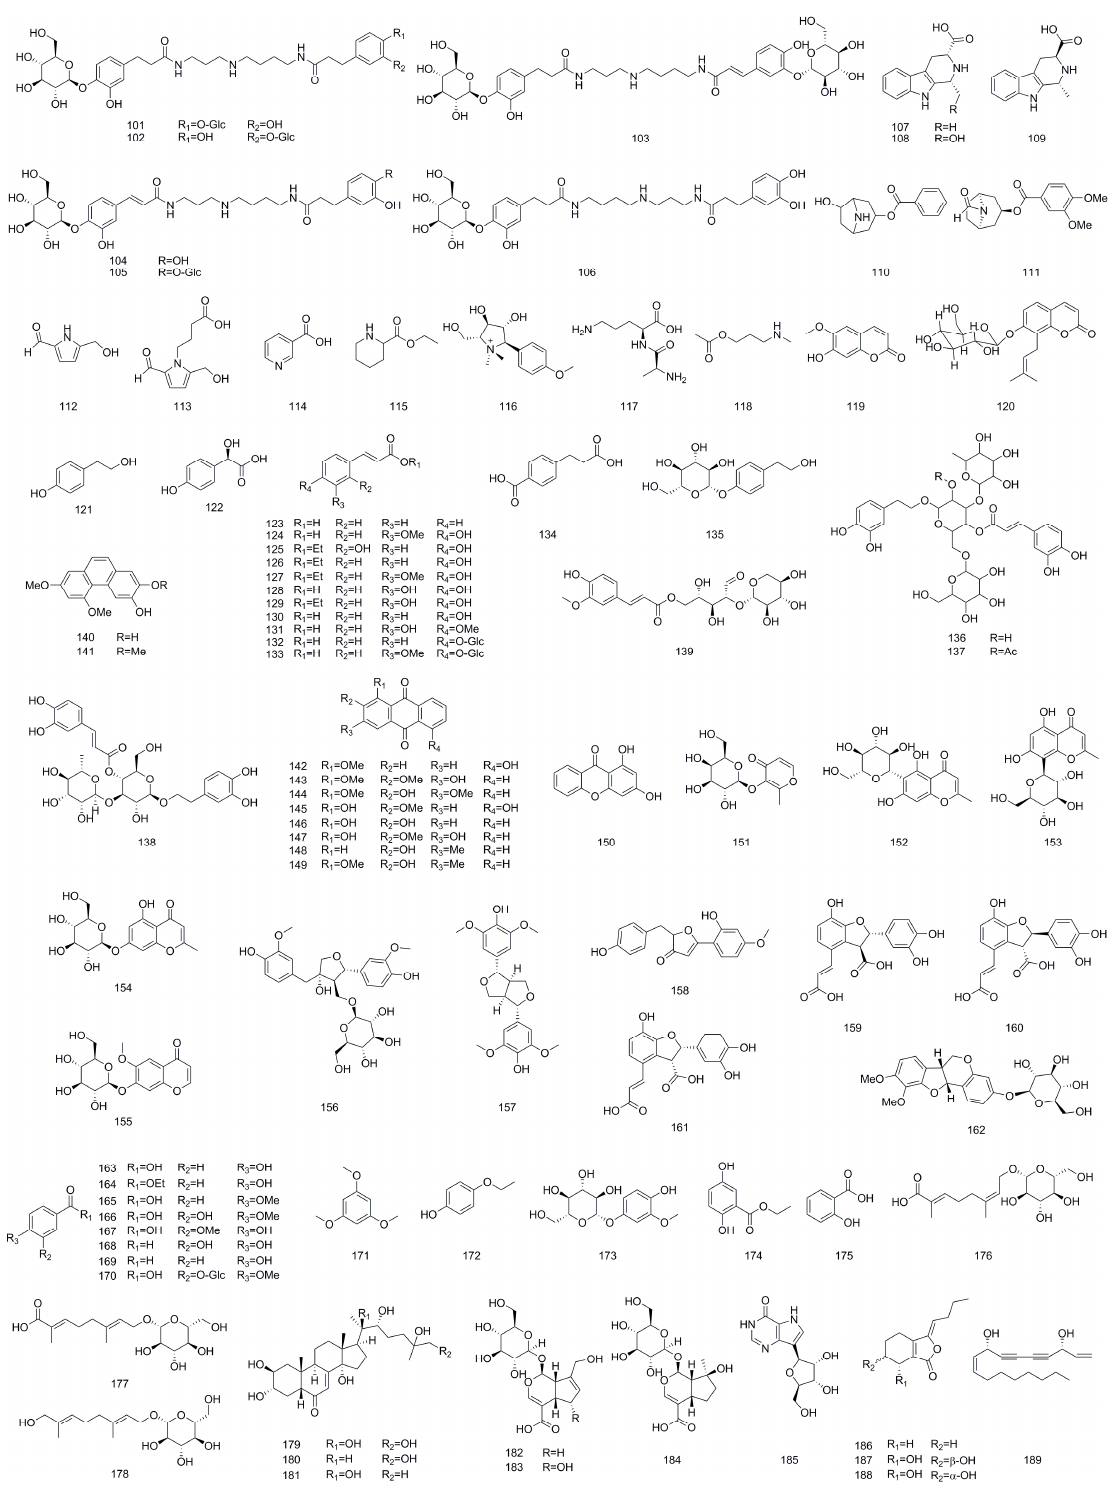
Figure 2. Structures of compounds 101 – 189 isolated from Jing liqueur.